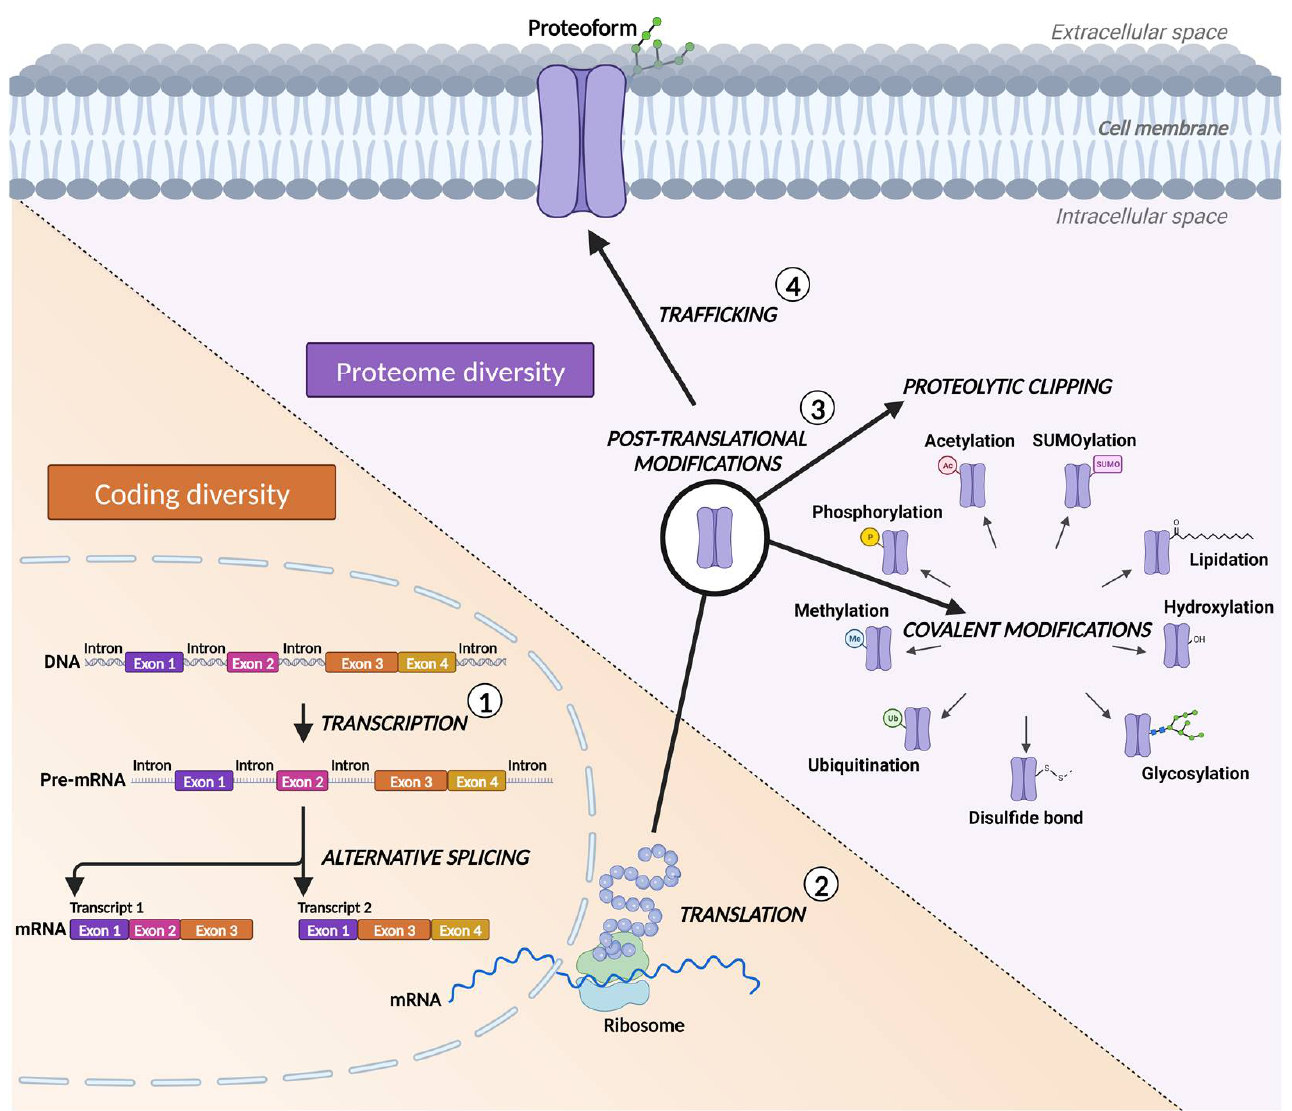
Figure 2. Coding and proteome diversity generate biological variation beyond the predictive power of initial DNA and mRNA sequences of encoded proteins through alternative splicing of mRNA and dynamic post-translational modifications of the proteins.